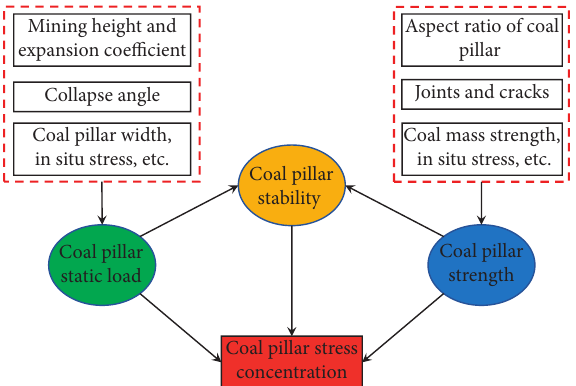
Figure 5: Principle of stress concentration in the coal